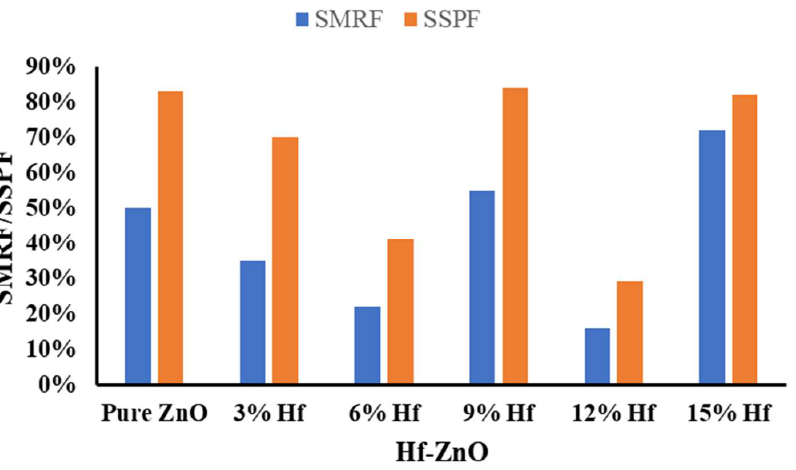
Figure 4. Solar material protection factor ( SMRF ) and solar skin protection factor ( SSPF ) for pure and different Hf-doped ZnO.